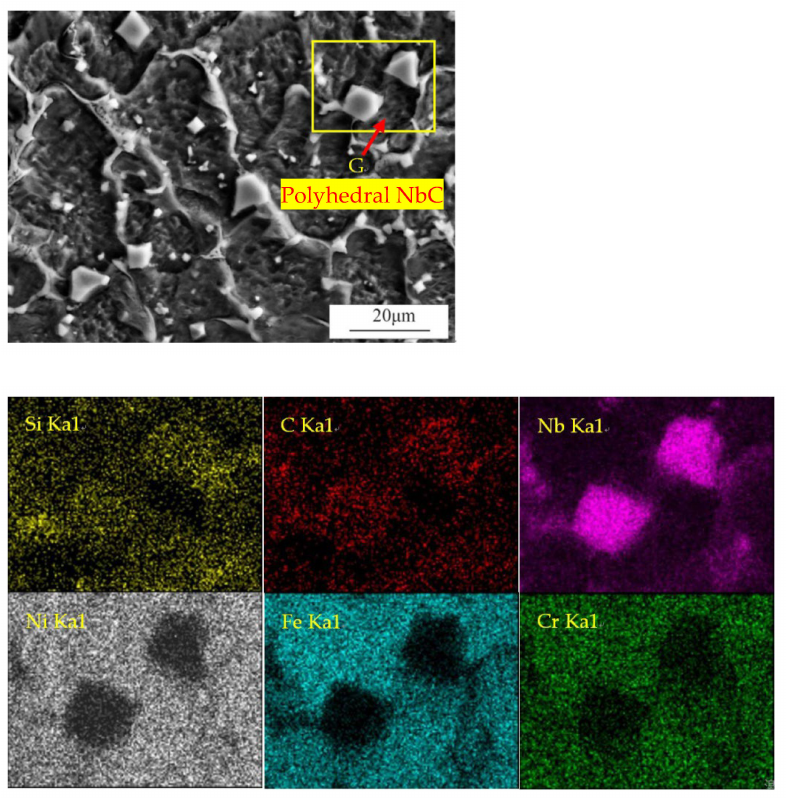
Figure 18. NbC in Cladding layer 5# and face-scanning analysis.